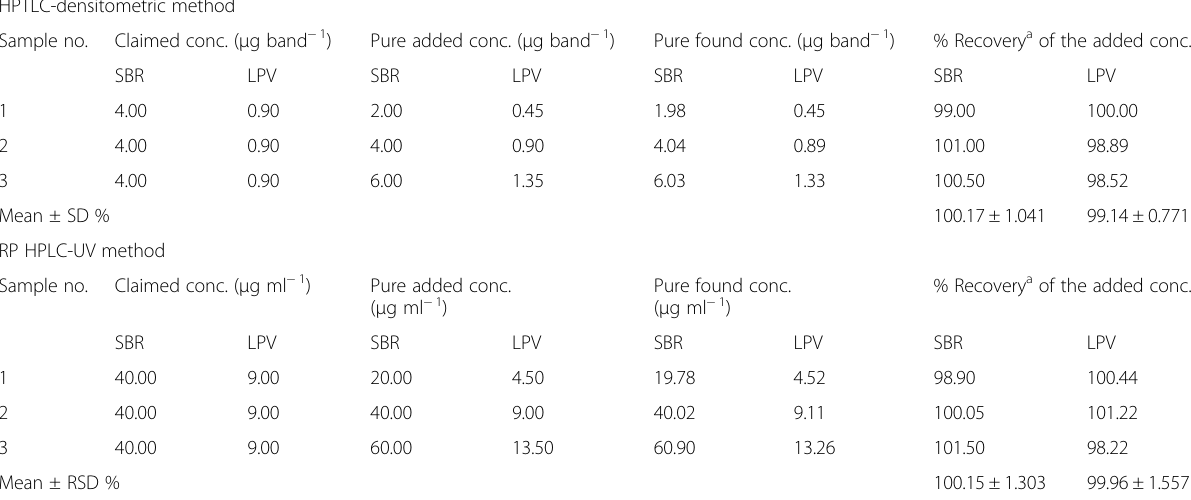
Table 6 Results of standard addition technique application on Heterosofir Plus® tablets to the simultaneous analysis of SBR and LPV using the proposed chromatographic methods HPTLC-densitometric method Sample